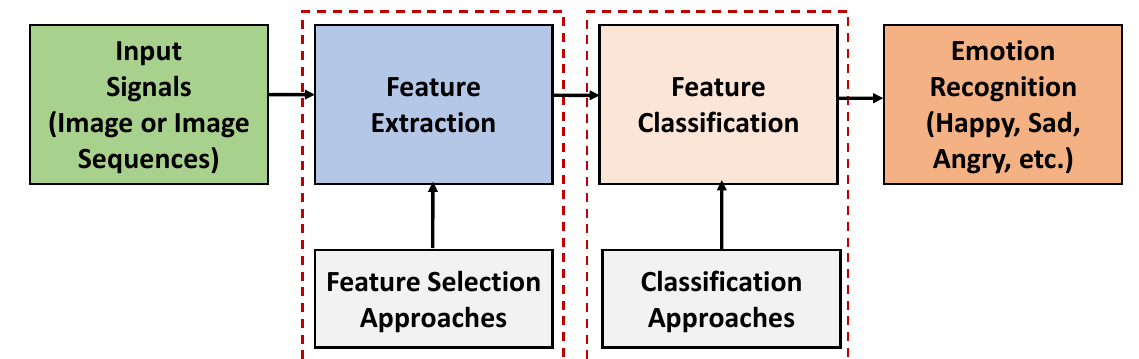
Figure 1. A simple process involved in the human emotion recognition